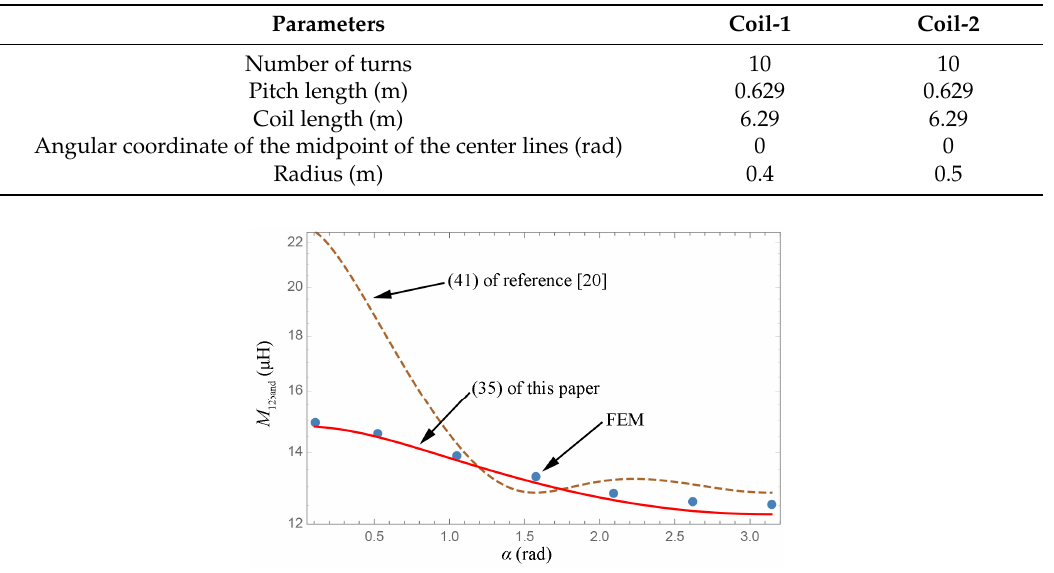
Figure 14. Tape-coil FEM model. From Figure 13, it can be observed that Equation (35) of this paper is in good agreement with the FEM; however, there are still certain deviations between Equation (41) of [20] and the above-mentioned two methods. It is worth noting that, when α approaches zero, the calculation result should approach the mutual inductance ( 14.82 μH ) of the filaments, with